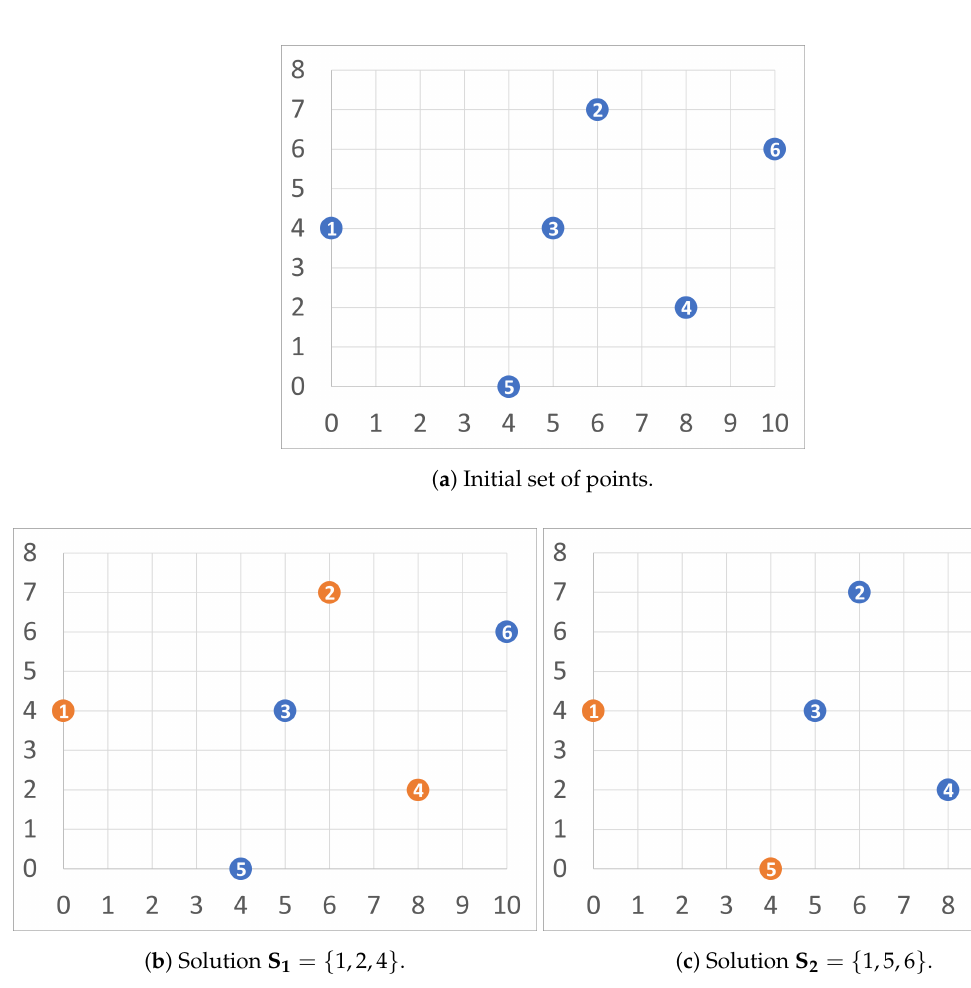
Figure 1. Instance with 6 available points where 3 of them must be